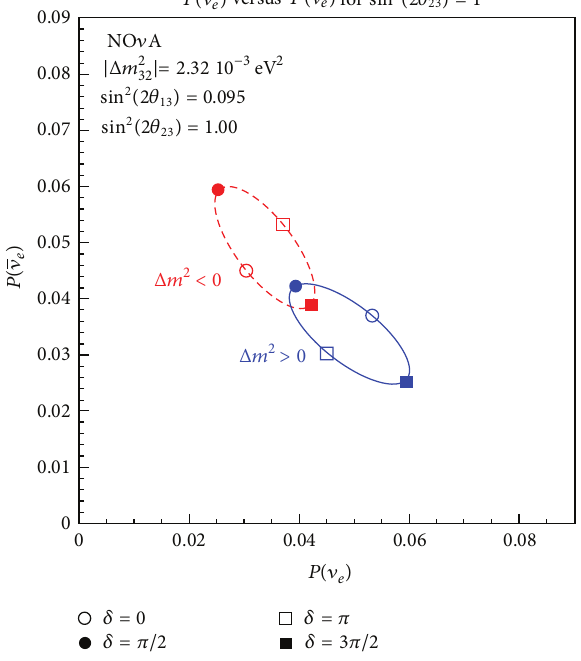
Figure 25: Biprobability plot for sin 2 (2𝜃 23 ) = 1.00 . See text for